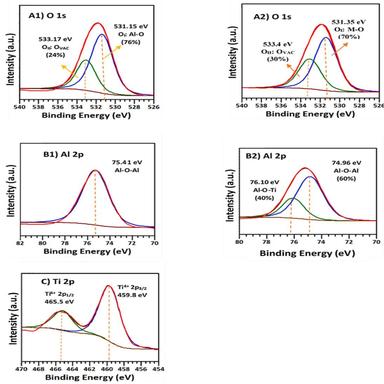
Fitted XPS spectra for A1) O 1s (γAl2O3), A2) O 1s (Ti-γAl2O3), B1) Al 2p (γAl2O3), B2) Al 2p (Ti-γAl2O3), C) Ti 2p (Ti-γAl2O3), D) Ti-γAl2O3, and E) Comparison of the O1s Ti 2p peaks for γAl2O3 and Ti-γAl2O3.